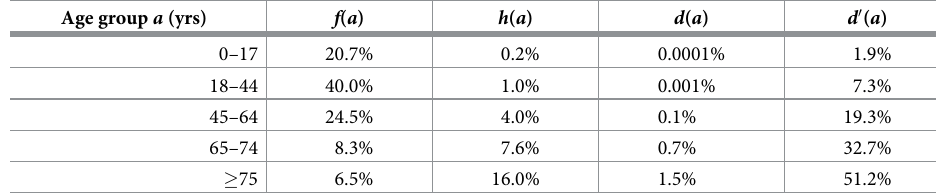
Table 1. Age-dependent mean hospitalization and mortality rates in the surrogate-world simulation. The share f ( a ) of the population in each age group a is taken from U.S. Census data [69]. The age-dependent death rate in hospi- tals d 0 is obtained from cumulative hospitalization and death rates in NYC by June 1, 2020 [36], under the assumption that 90% of deaths occurred in hospitals. Age-dependent hospitalization rates h ( a ) and mortality rates d ( a ) in the com- munity (outside hospitals) are difficult to obtain directly from NYC data because of an age-dependent undercount of infections [37]. We choose hospitalization rates h ( a ) that approximate data from France [70], adjusting the rates so that the overall hospitalization rate is ∑ ( a ) h ( a ) � 3.1%, which is NYC’s overall hospitalization rate if one assumes a cumu- a f lative COVID-19 incidence rate of 23% [71], together with NYC’s actual hospitalization count (52,333 on June 1, 2020) and population (8.34 million) [36]. Similarly, the mortality rate in the community d ( a ) is chosen such that the overall infection fatality rate is ∑ ( a )[ d ( a )+ h ( a ) d 0 ( a )] � 1.1%, which is NYC’s overall infection fatality rate if one considers a f the same cumulative incidence of 23% and the confirmed and probable cumulative death count from